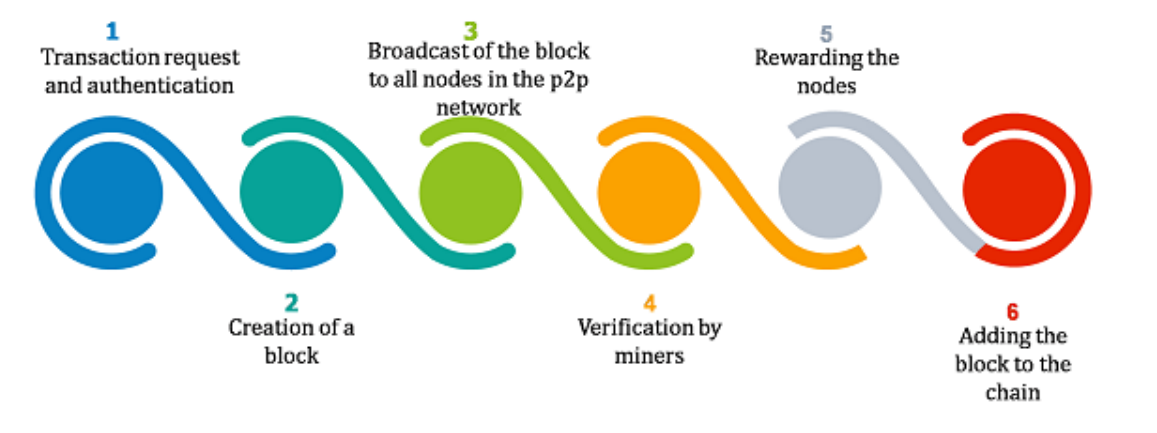
Figure 5. A blockchain